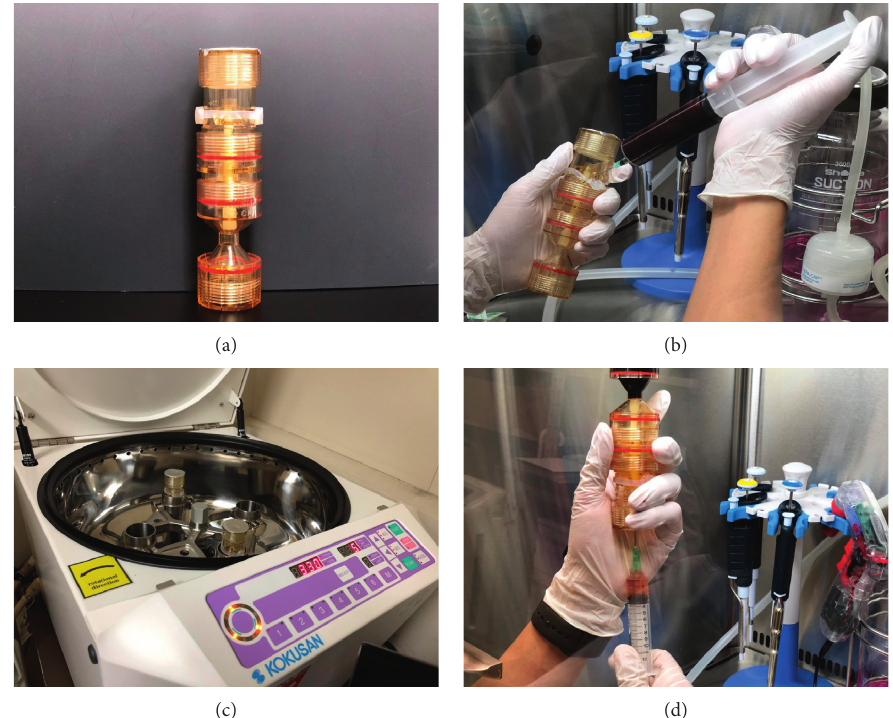
Figure 1: PRP preparation using the TriCell PRP Kit. (a) Collection tube from the TriCell PRP Kit before use. (b) Injection of whole blood into the upper part of the tube. (c) Centrifugation of the tube. (d) Collection of buffy coats containing platelets after adjusting platelet separation closing gap between the upper and lower